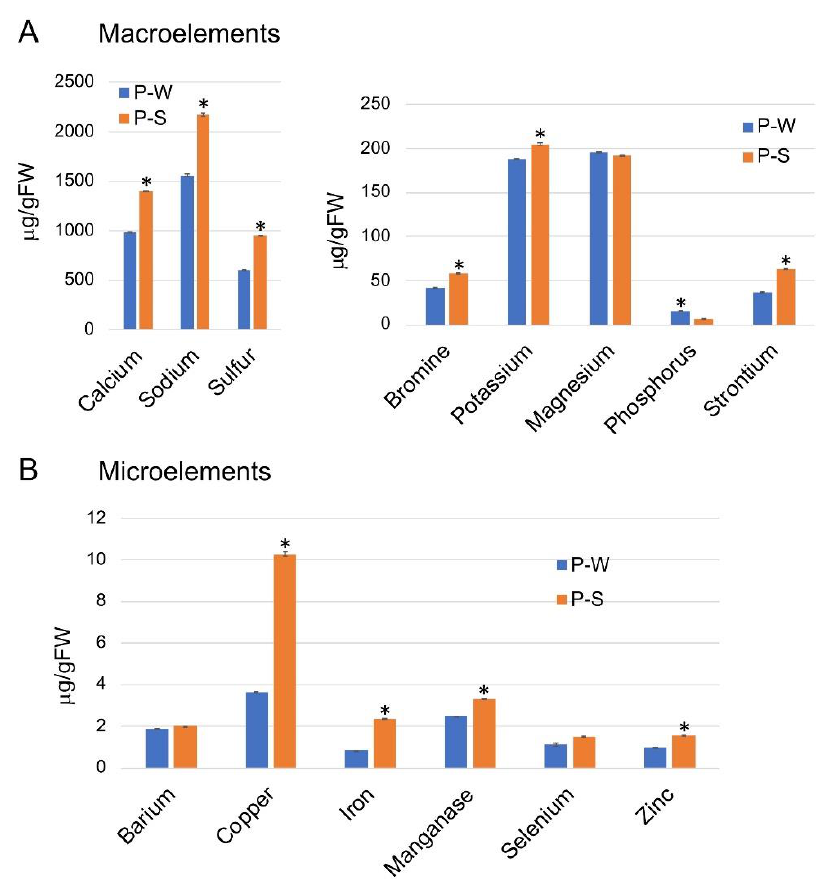
Figure 6. Nutrient profiles of Z. dumosum petioles during the winter (P-W) and the summer (P-S) months. Petioles extracts were subjected to ICP-OES (4 repeats) to detect ( A ) macroelements and ( B ) microelements. Vertical bars represent the standard deviation. Asterisks indicate statistically significant differences in element concentration between winter and summer petioles ( p < 0.05; Student’s unpaired t -test).